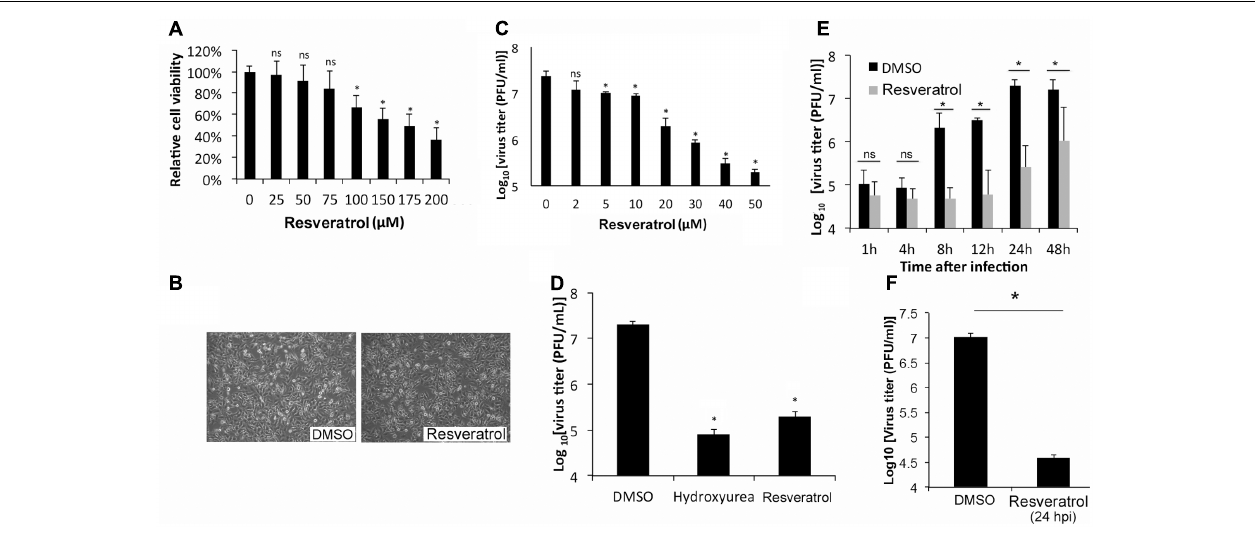
FIGURE 1 | Resveratrol suppresses VACV replication in HeLa cells. (A) HeLa cells were treated with DMSO or resveratrol at the indicated concentrations for 24 h. Cell viability was measured using trypan blue exclusion test. (B) HeLa cells were imaged under the bright field of a microscope after DMSO or resveratrol (50 µ M) treatment for 24 h. (C) HeLa cells were infected with VACV at an MOI of 1 in the presence of resveratrol at the indicated concentrations. Virus yield at 24 hpi were determined by a plaque assay. (D) HeLa cells were infected with VACV at an MOI of 1 in the presence of DMSO, hydroxyurea (10 mM), or resveratrol (50 µ M). Virus yield at 24 hpi were determined by a plaque assay. (E) HeLa cells were infected with VACV at an MOI of 0.01 in the presence of DMSO or 50 µ M resveratrol. Virus titers were determined by a plaque assay at the indicated time points. (F) HeLa cells were infected with VACV at an MOI of 0.001 treated with DMSO or 50 µ M resveratrol at 24 hpi. Virus titers were determined by a plaque assay at 72 hpi. The asterisk indicates significant difference ( P < 0.05) and the ns indicates no significant difference between DMSO-treated cells and resveratrol- or hydroxyurea-treated cells. The error bar indicates standard deviation.